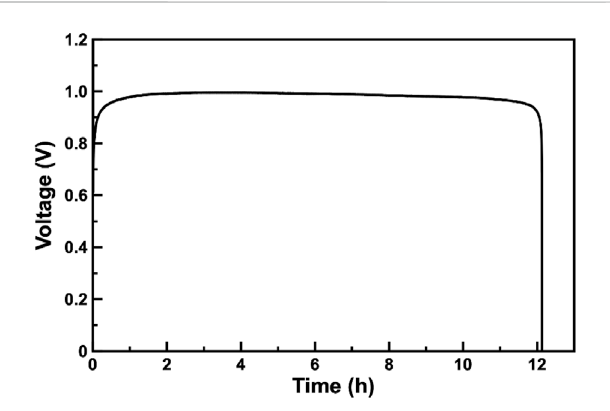
FIGURE 3 Galvanostatic discharge curve of ZAB at a constant current density of 10 mA cm − 2